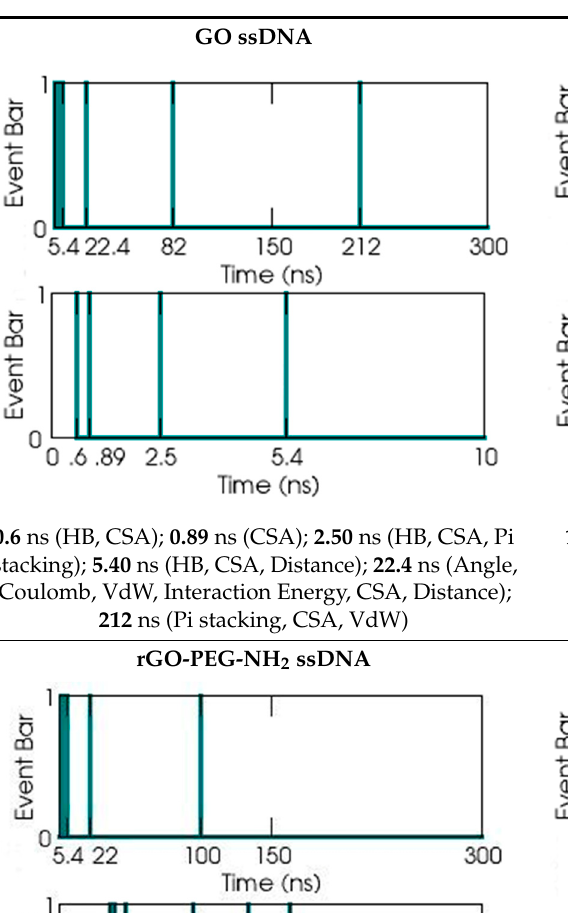
Table 1. Summary of all events throughout the 300ns simulated time for each of the four presented cases. The specific time of each event is then associated to the graphs displaying a change in value, which were referenced in the description of events.